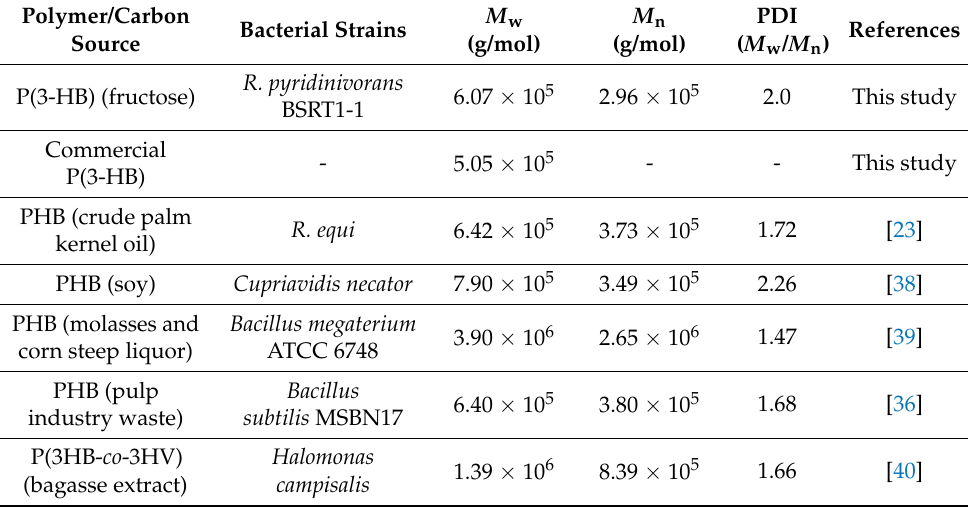
Table 1. The weight ( M w ) and number ( M n ) -average molecular weight and respective polydispersity index (PDI) ( M w / M n ) of the P(3-HB) produced by R. pyridinivorans BSRT-1, and comparison with other reports.